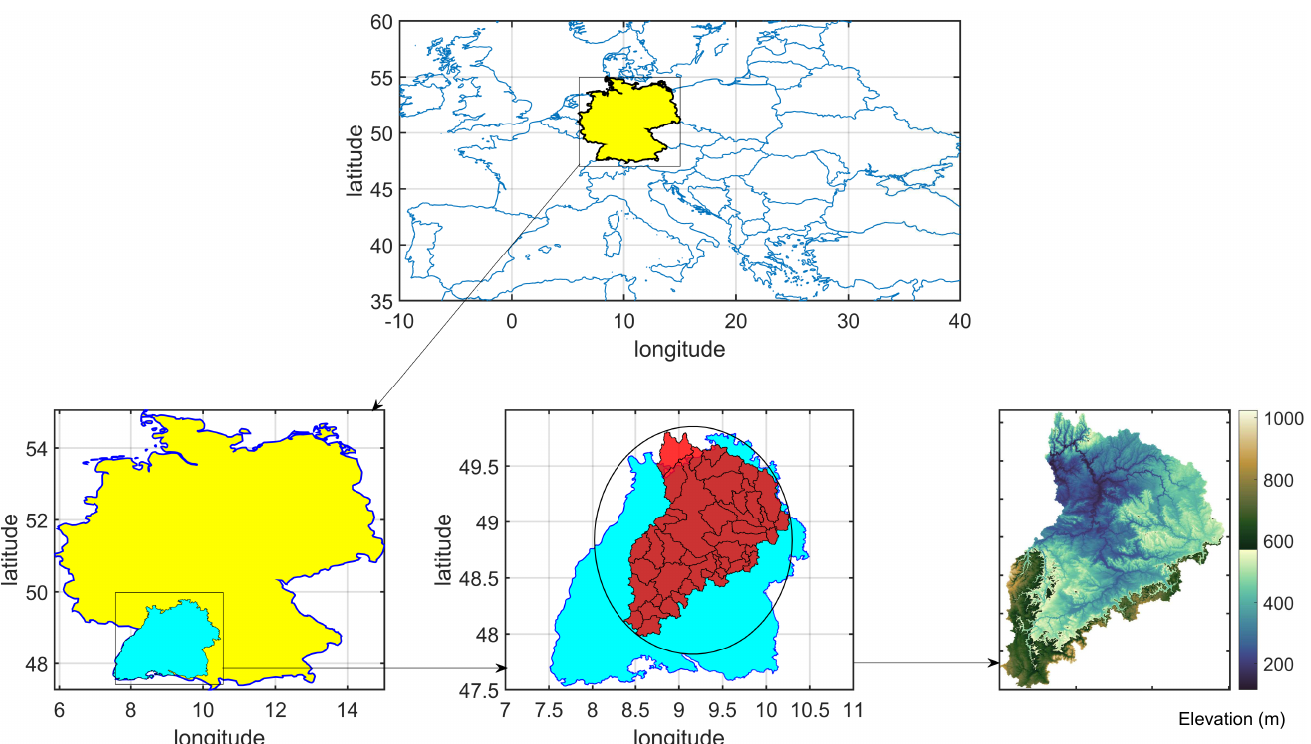
Figure 1. Location of the Neckar catchment in the southwest of Germany; yellow: Germany, cyan: the state of Baden- Württemberg, red: the Neckar catchment and its 46